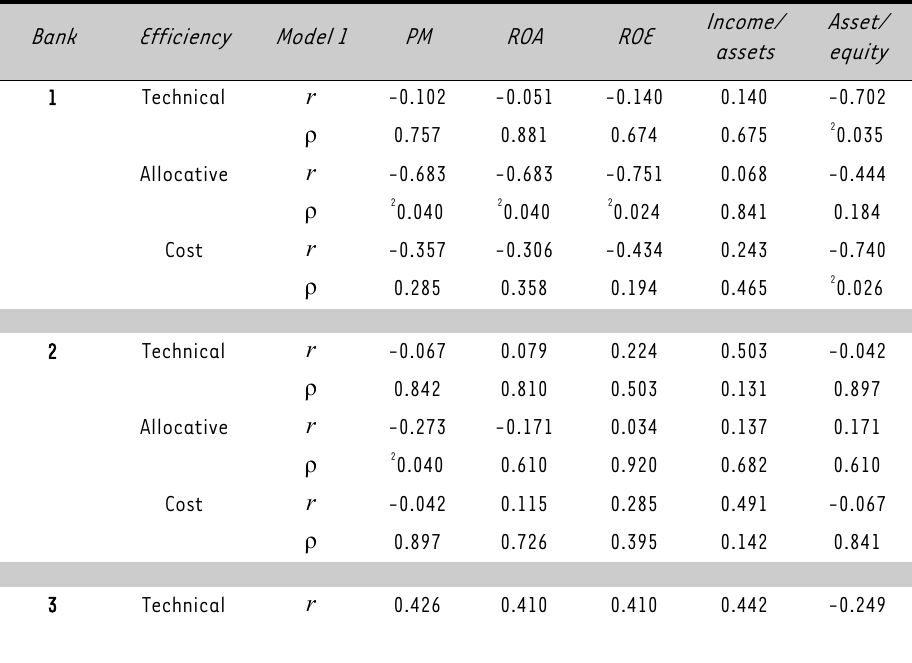
TABLE 2: Correlation coefficient ( r ) between DEA estimates in Model 1 and financial ratio analysis, and testing of the hypothesis ( ρ